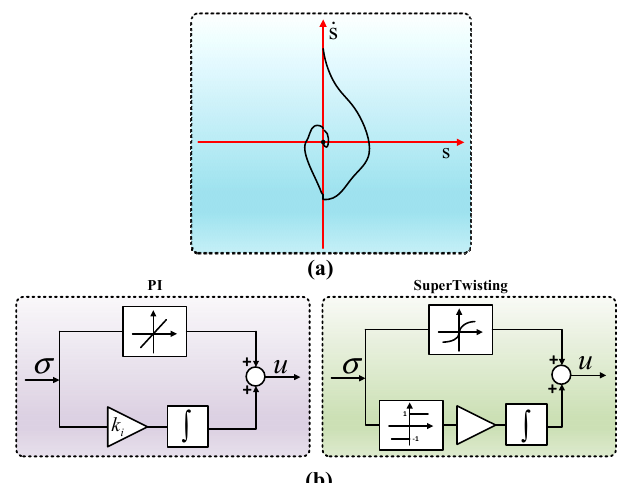
Figure 4. ( a ) Phase trajectory of the Super Twisting algorithm [66] ( b ) comparison of Super Twisting controller with PI [61].